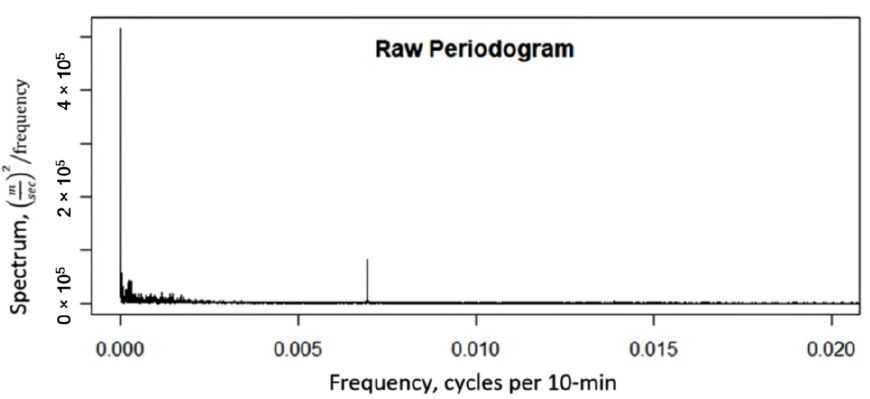
Figure 4. The periodogram of 10 min average wind speed at a 100 m height.